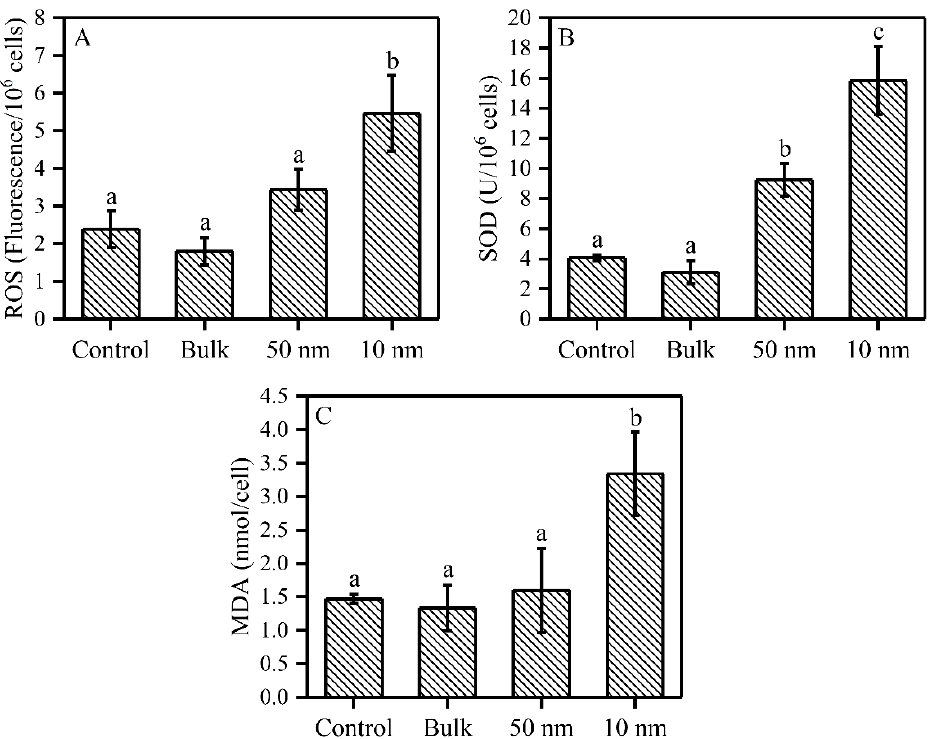
Figure 3. ROS, SOD and MDA contents of S. obliquus under three sizes of TiO 2 exposure after 72 h. ( A ) ROS content; ( B ) SOD activity; and ( C ) MDA content. Different letters on the error bars show significant (Tukey’s HSD, p < 0.05) differences. Values are represented as means ± SD ( n = 3).